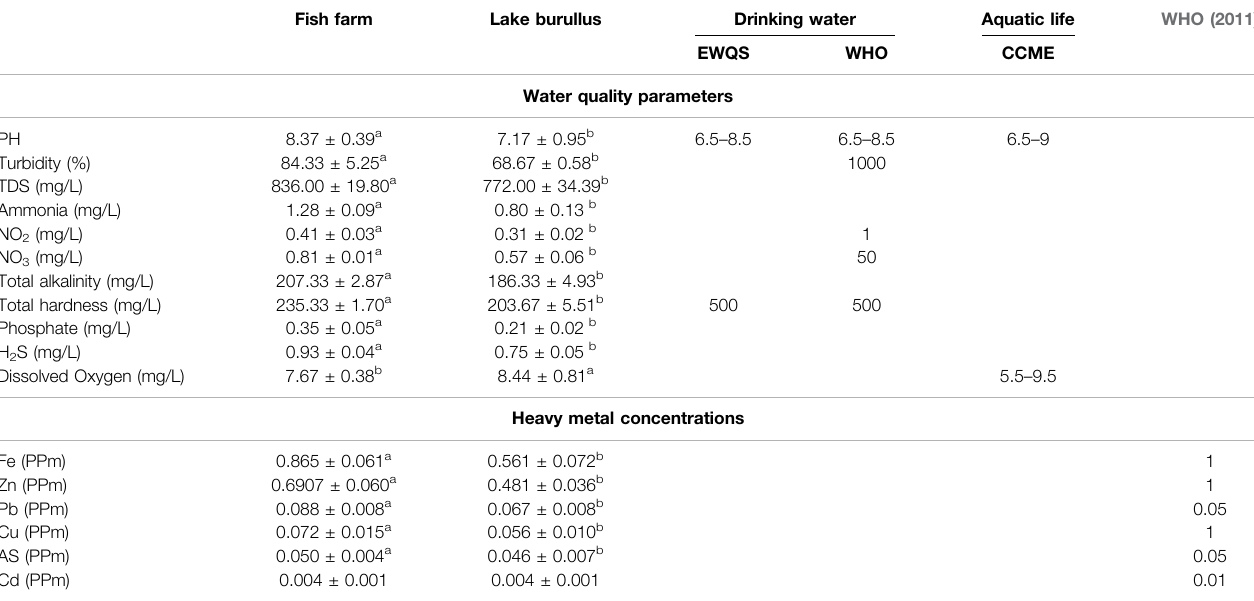
TABLE 1 | Water quality parameters and heavy metal concentrations of the water collected from fi sh farm and Burullus Lake. At p < 0.05, results from the same row with different alphabetic letters are statistically different.